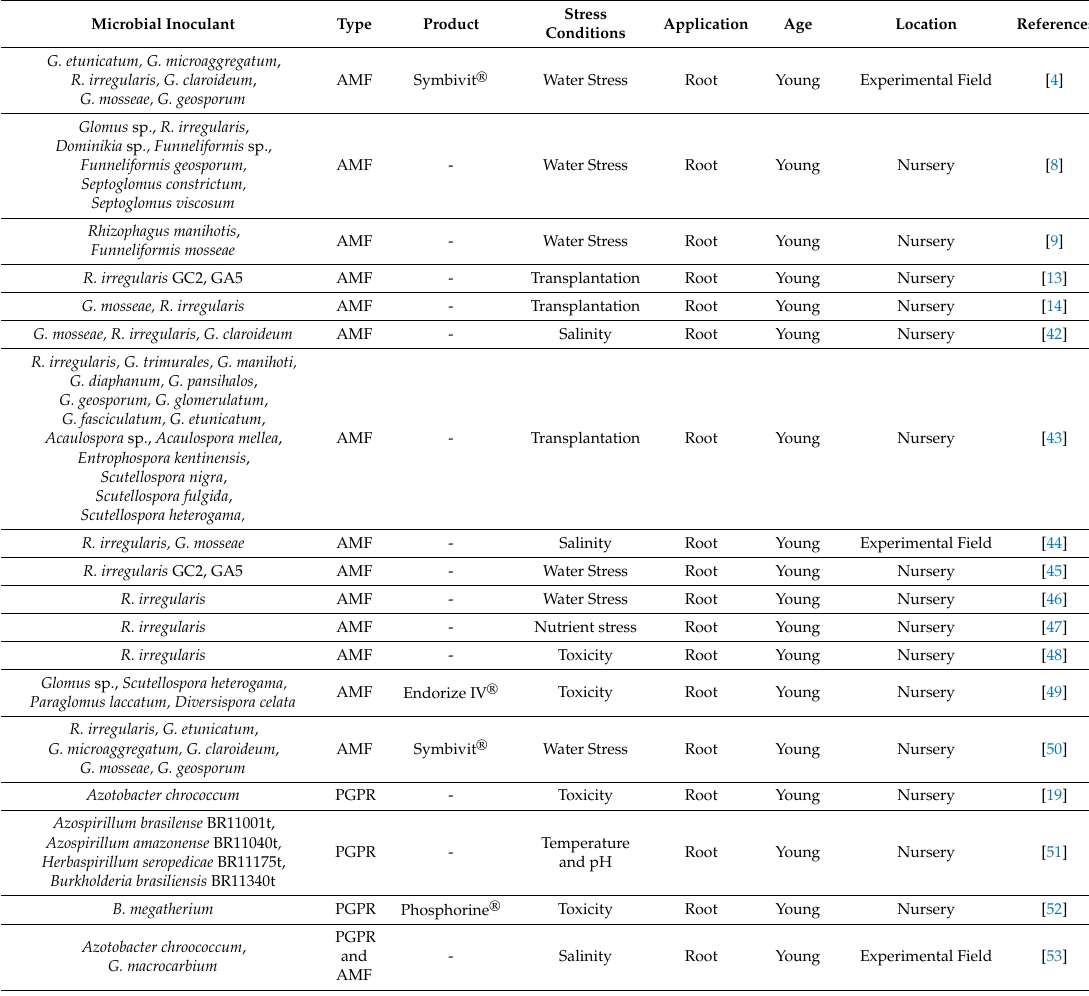
Table 2. Microbial inoculant studies aiming on the alleviation of abiotic and transplantation stresses. Microbial